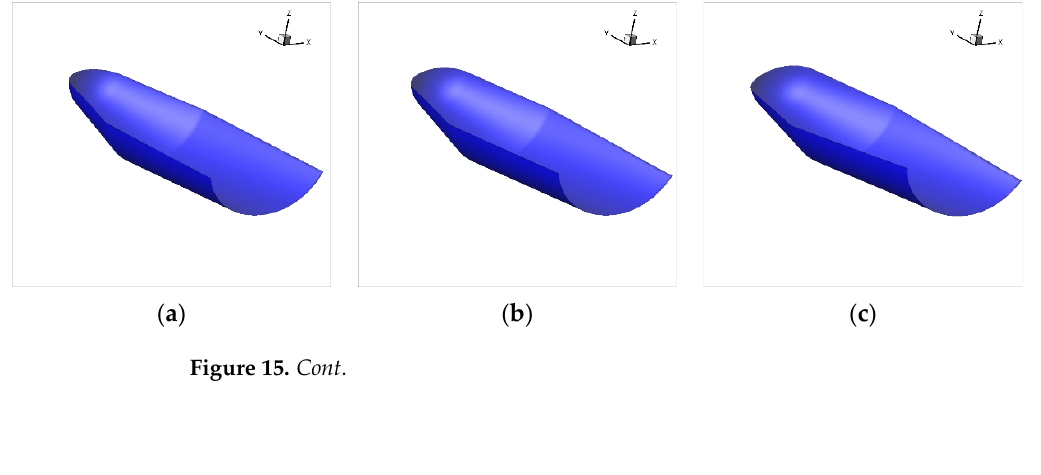
Figure 14. Spectral analysis of the X displacement of the monitoring point. ( a ) Deformation in the X direction. ( b ) PSD of deformation in the X direction.